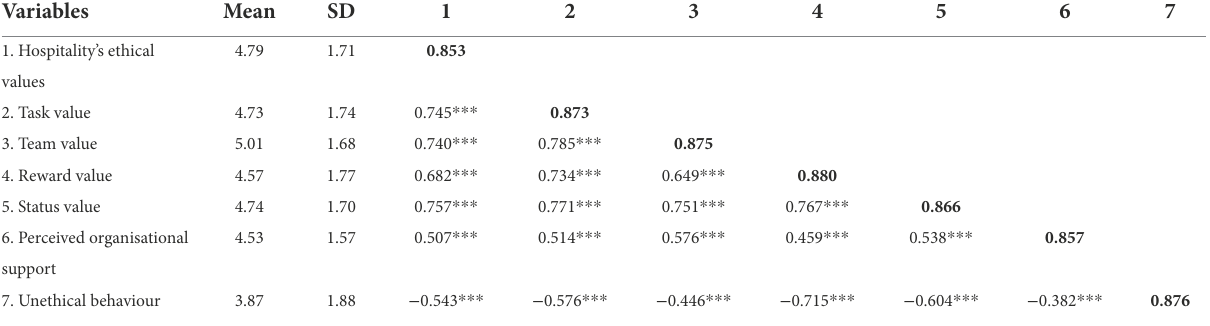
TABLE 3 Means, standard deviations, correlations and discriminant validity.